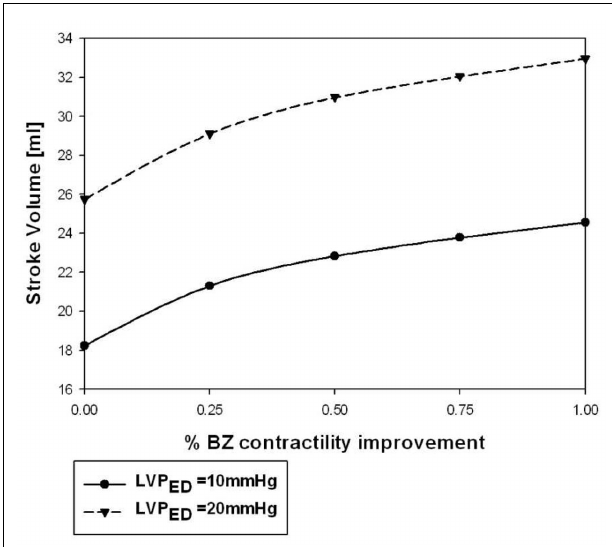
FIGURE 5 | Stroke volume at LVP ED = 10 and 20mmHg varied when BZ-contractility restored from 0 (INJURED) to 100%